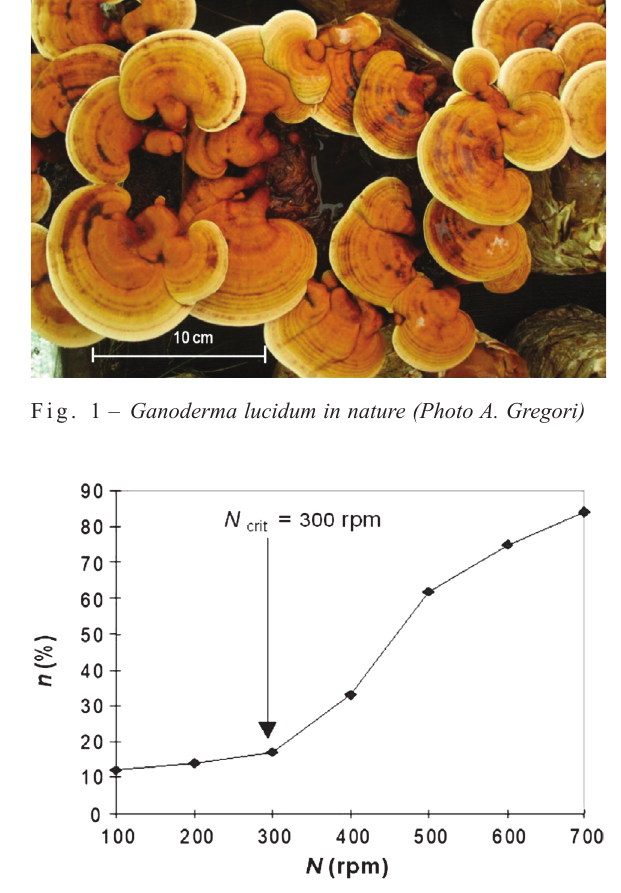
Fig. 2 – Critical agitation speed for hyphae damage in Gan- oderma lucidum cultivation in stirred tank reactor; n (%) percentage of hyphae